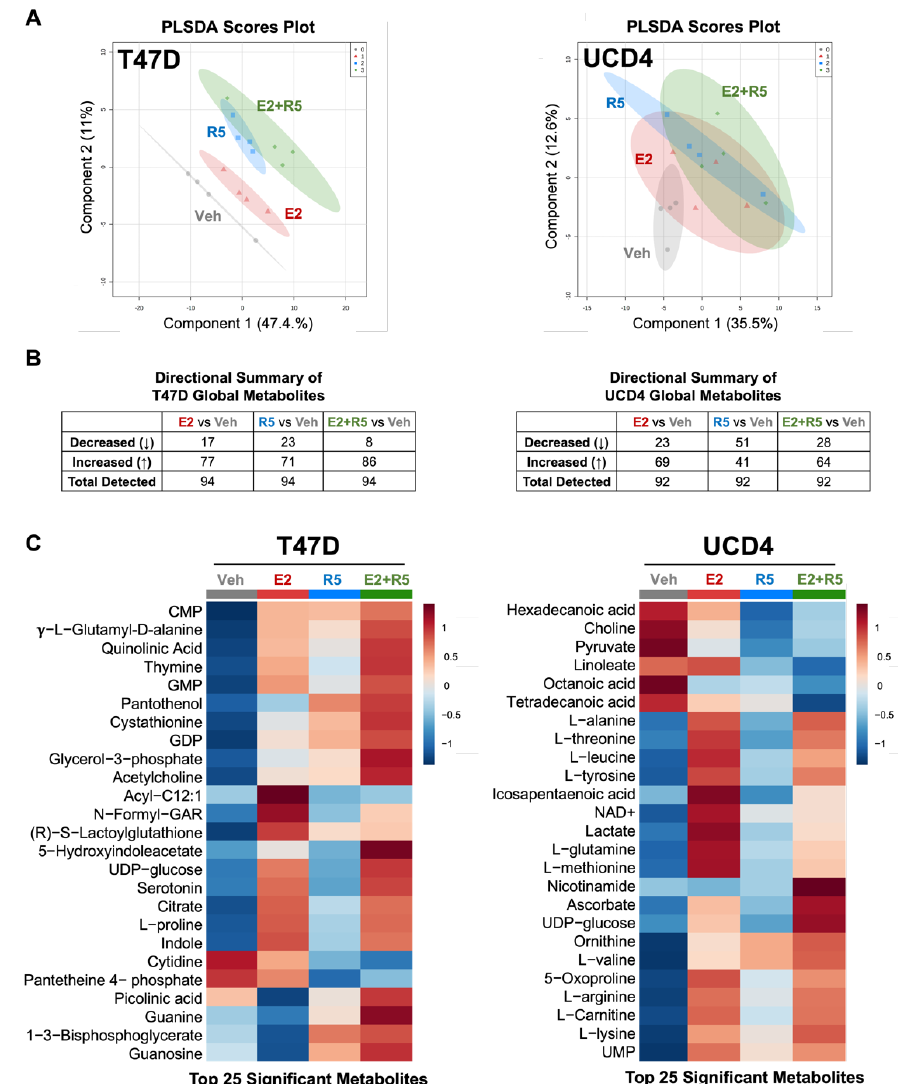
Figure 1. Estrogens and progestins alter global metabolites in T47D and UCD4 breast cancer cells. Untargeted metabolomics was conducted on samples of T47D and UCD4 breast cancer cell lines treated with E2 (10 −8 M), promegestone (R5, 10 −8 M), E2 + R5 (10 −8 M each), or ethanol (Veh) for 24 h ( n = 4 per treatment condition). Metabolomics data were normalized to cell count, log transformed, and auto-scaled in MetaboAnalyst. ( A ) PLSDA scores plots of T47D or UCD4 samples stratified by hormone treatment. Shaded areas indicate 95% confidence regions; ( B ) directional summary of metabolites for T47D and UCD4 samples with each hormone treatment compared to vehicle. Decreased and increased metabolites were determined by a negative or positive fold change value from vehicle samples, respectively; ( C ) hierarchical clustering heatmaps of the top 25 significant metabolites in T47D and UCD4 samples by ANOVA multiple comparisons. Heatmaps were generated using Euclidean distance measure and Ward clustering method. Samples were averaged by treatment ( n = 4).